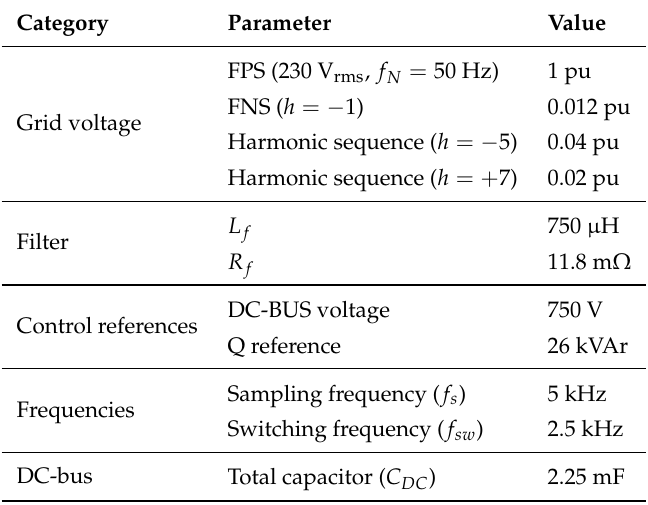
Table 2. Experimental setup